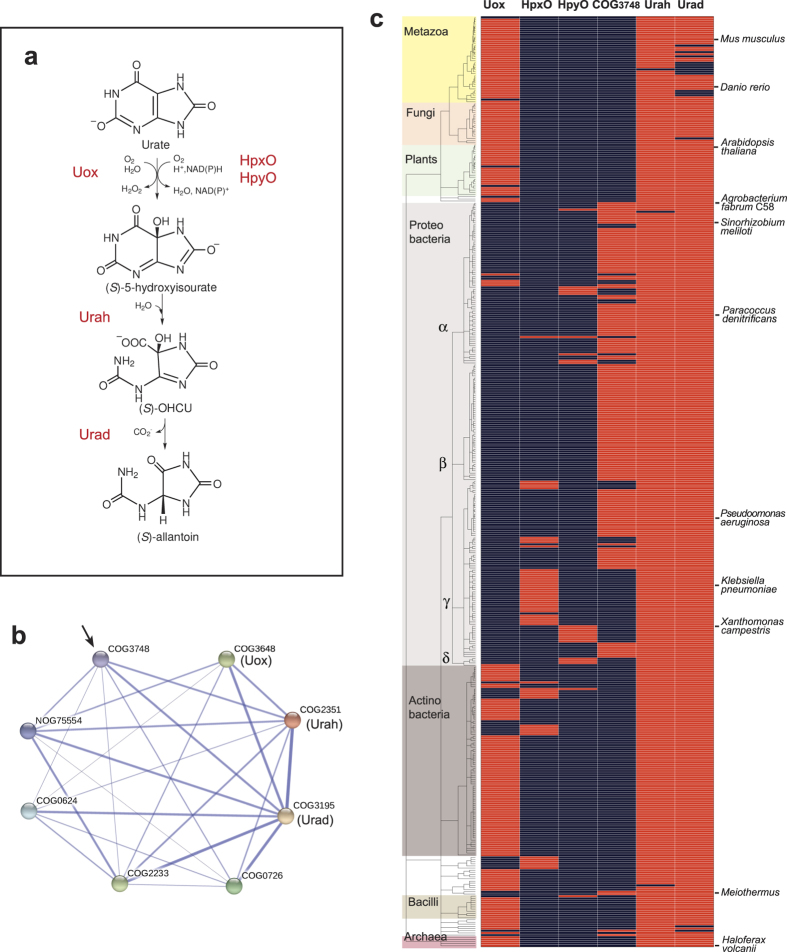
Identification of COG3748 as urate oxidase.(a) Pathway for the conversion of urate into allantoin. (b) String association network obtained with COG3648, COG2351, and COG3195. Nodes represent gene families according to the COG classification. Edges represent predicted functional associations; stronger associations are shown as thicker lines. The node identified as a candidate urate oxidase (COG3748) is indicated with an arrow. (c) Map of urate oxidation capacity in complete genomes. The tree represents 431 distinct species possessing either the uox, hpxO, hpyO, or COG3748 genes or both the urah and urad genes. The presence (red) or the absence (blue) of genes in complete genomes is shown alongside the organism tree. Main taxonomic groups and organisms discussed in the text are indicated.